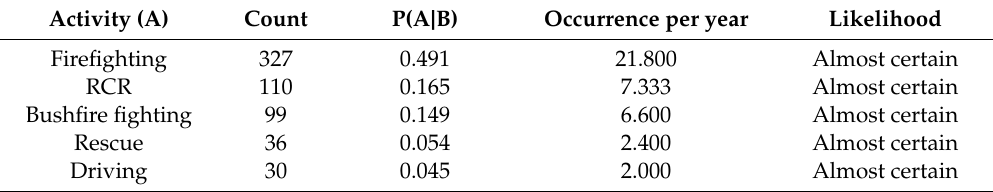
Table 1. Analysis by